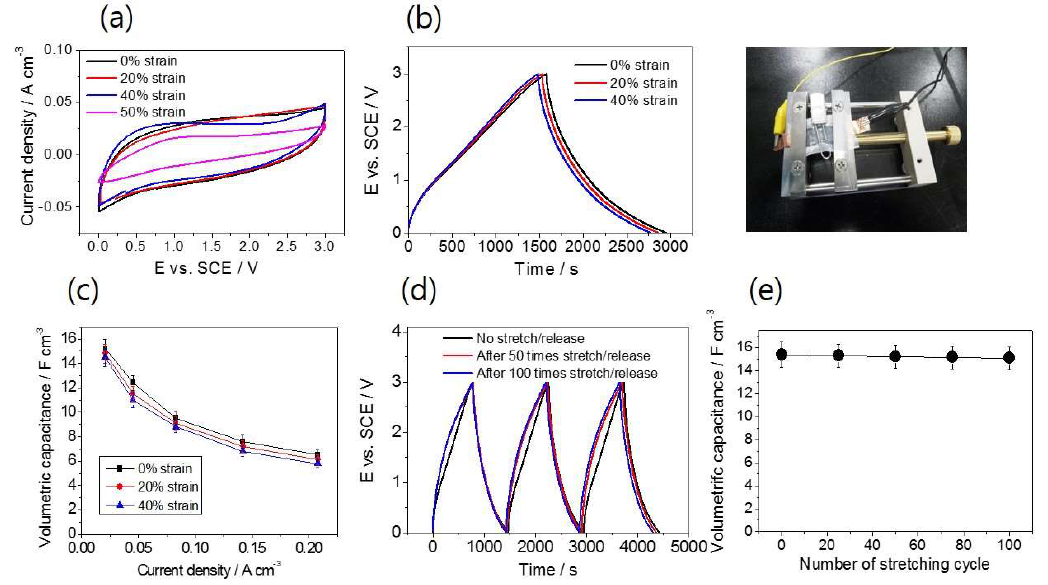
Figure 6. Electrochemical performance of the supercapacitors upon stretching. ( a ) Cyclic voltammograms for devices under 0%, 20%, and 40%, and 50% strain; ( b ) Galvanostatic charge/discharge curves for a devices under 0%, 20%, and 40% strain; and on the right, a photograph taken during a stretching experiment; ( c ) Volumetric capacitance as a function of discharge current density for devices under 0%, 20%, and 40% strain; ( d ) Galvanostatic charge/discharge curves at a current density of 0.045 A cm − 3 following 0, 50, and 100 times of repeated stretch/release cycles at 40% strain; ( e ) Variation of volumetric capacitance after the different number (0, 25, 75, and 100) of stretch/release cycles.